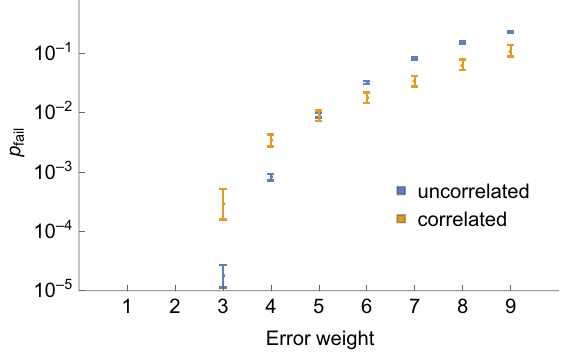
FIG. 42. Performance of the modified restriction decoder for the 3D color code for distance d = 9 given various error weights. Uncorrelated Z noise (blue) of weight w is generated by ran- domly selecting w of the n qubits and applying a Z error. Correlated Z noise (yellow) is generated by running the decoder for error rate p = 0.0003, and for each error generated, esti- mating its stabilizer-reduced weight w by taking the smaller of the weight of the error itself and its correction. The correlated and uncorrelated cases are not identical but are very similar, justifying our